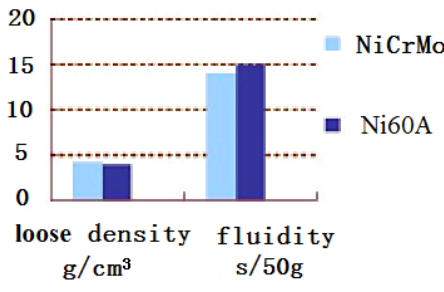
Figure 4. The apparent density and flowability of the powders.